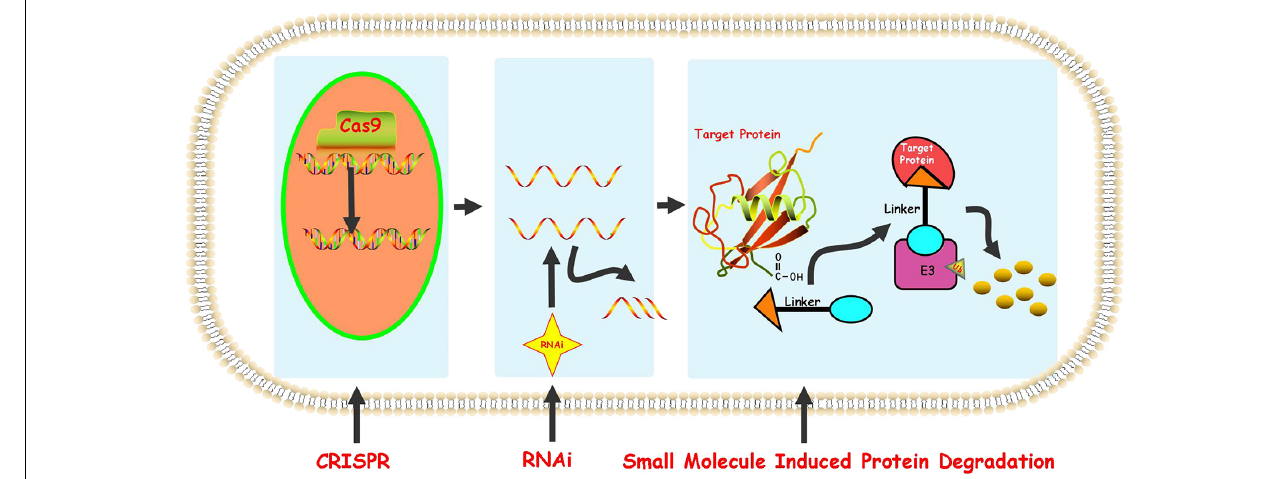
FIGURE 2 | Protein knockdown strategies.